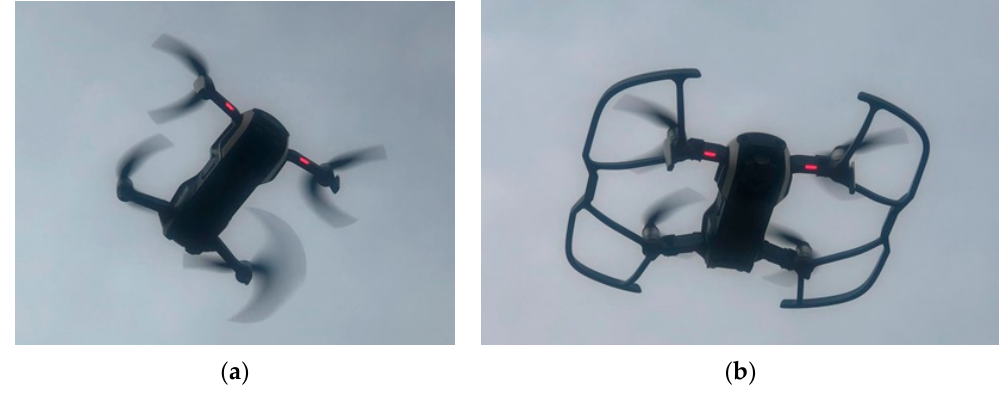
Figure 1. Mavic Air: ( a ) without protector and ( b ) with protector.